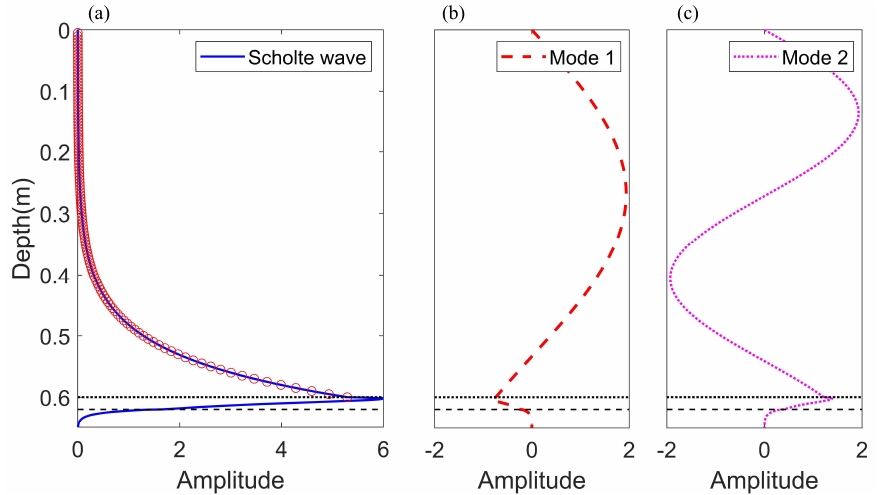
Figure 4. Pressure mode functions for a 50kHz source; the red circles represent the receiver positions. ( a ) Scholte wave. ( b ) Mode 1. ( c ) Mode